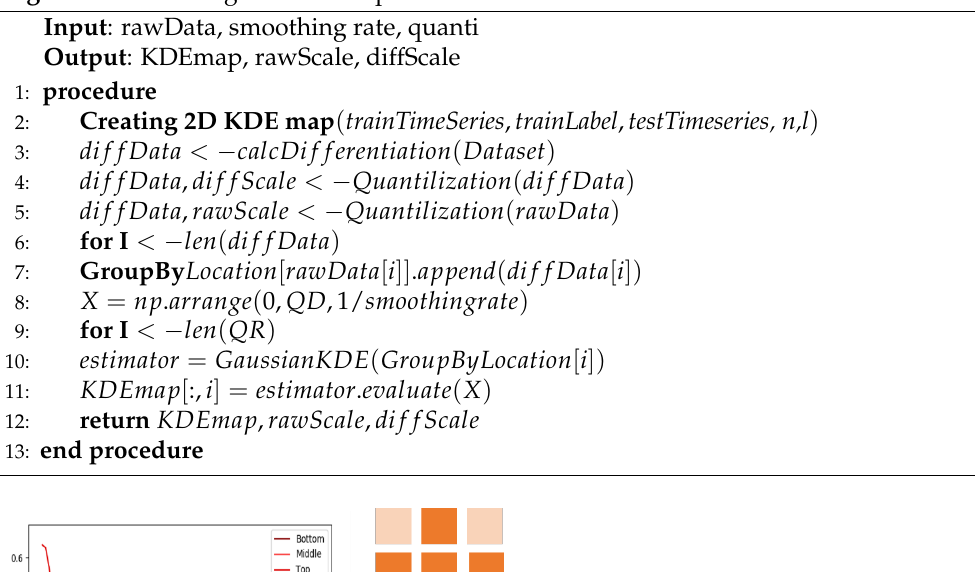
Algorithm 1 Creating 2D KDE map